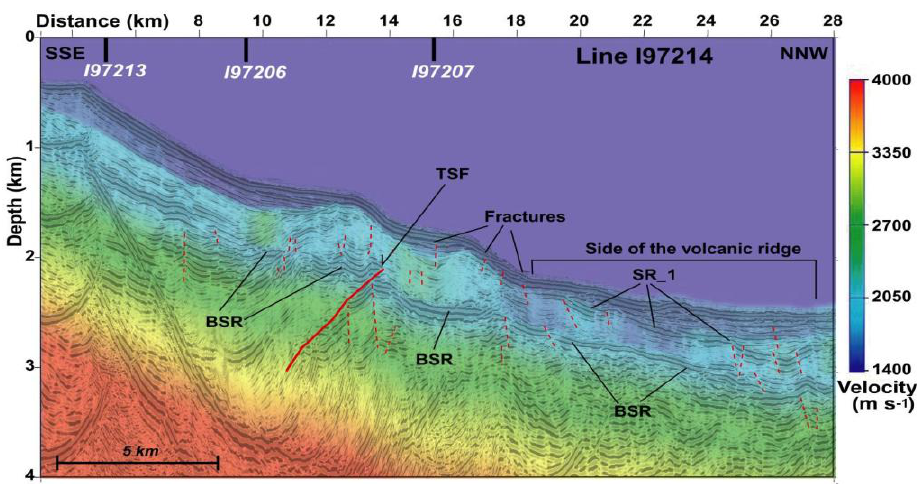
Figure 6. PreSDM of line I97214, on which the velocity model is superimposed. The BSR and the main geological features are indicated. Fractures are indicated with dashed red lines. TSF: Thrust Fault System; SR_1: Seismic Reflector 1; Vertical exaggeration 1:4; Crossing lines are